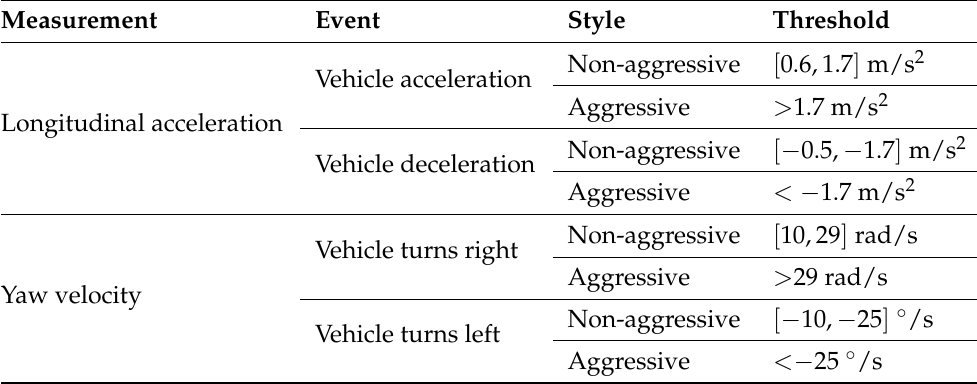
Table 2. Threshold definition for driving style using the heuristic-based rules